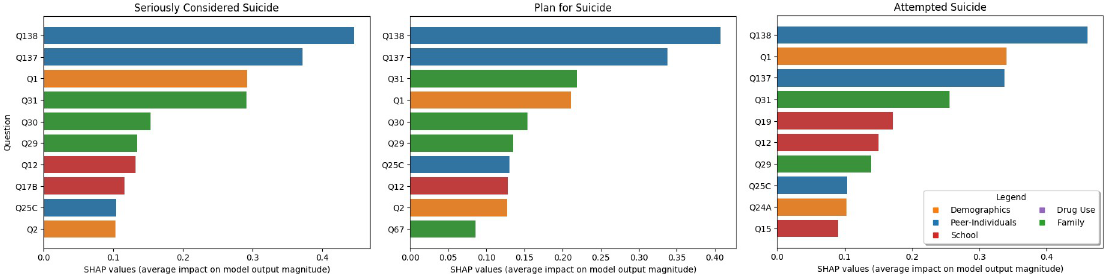
Fig 9. The top 10 most important questions for the varying levels of suicidal thoughts and behavior. Note that compared to Fig 3 the majority are the same. For the target question about “Attempted Suicide” we see the largest difference, with the focus shifting more to the importance of gender (Q1) and school performance (Q15 and